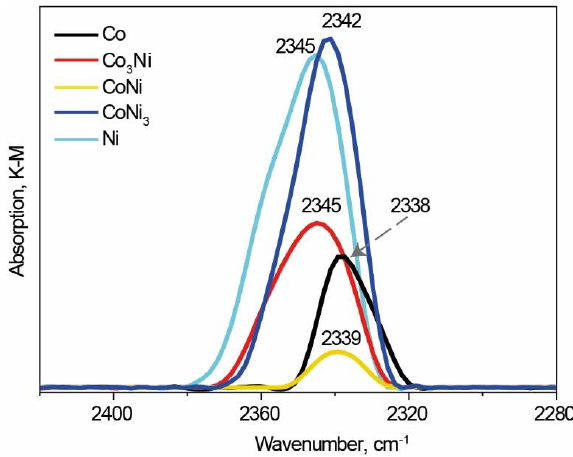
Figure 4. DRIFT-CO 2 spectra of Co, Ni, and bimetallic Co x Ni 1 – x catalysts.